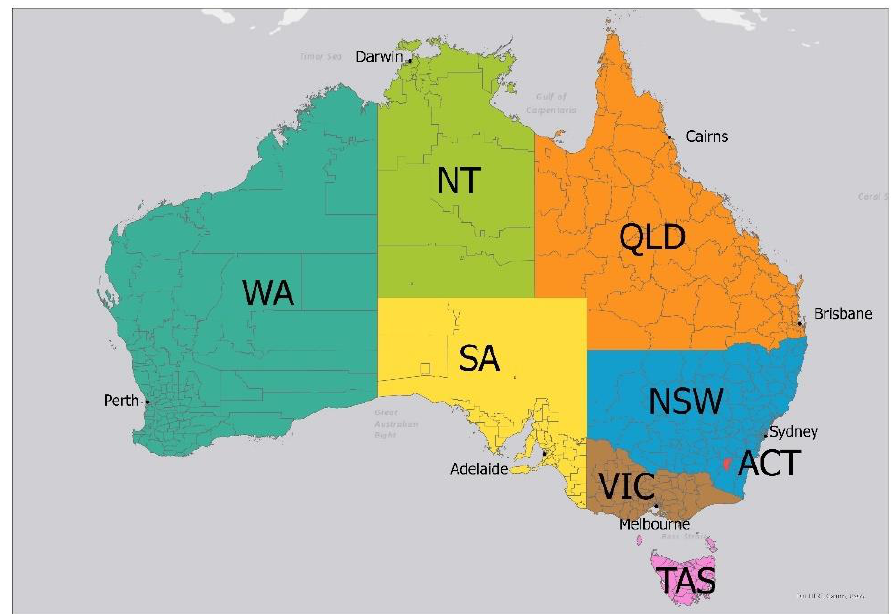
Figure 1. Map of the study area, state, and territory boundaries as well as Local Government Area (LGA) divisions and major cities. States and territories: Western Australia (WA), Northern Territory (NT), Queensland (QLD), South Australia (SA), New South Wales (NSW), Australian Capital Territory (ACT), Victoria (VIC), and Tasmania (TAS) are labelled. Table 1. Comparison table of each Australian state’s general characteristics: Area, Number of LGAs, Average area per LGA, Gross State Product (GSP), Population, and GSP per capita (Australian Bureau of Statistics, 2020–2021).